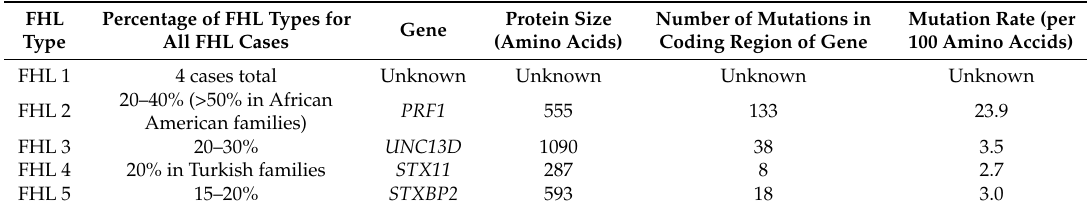
Table 2. Summary of FHL Incidence. Listed are each FHL subtype, the percentage of particular subtypes in respect to all FHL cases, the etiological gene, and the gene size. Amount of mutations in coding region of gene was calculated using mutations found in Leiden Open Variation Dataase, NCBI SNP database, and primary